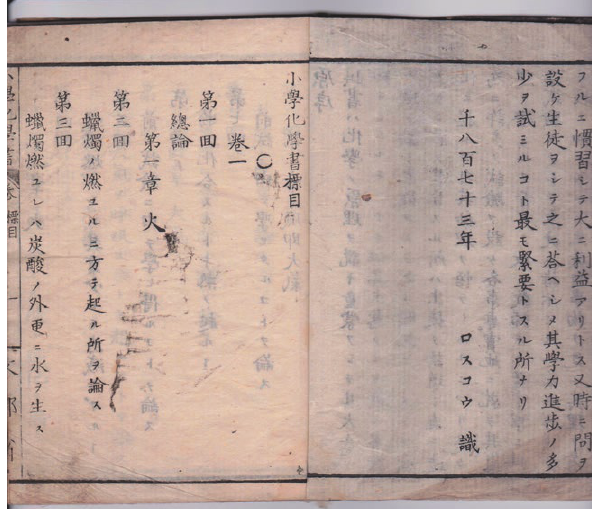
Figure 2. Front page of Roscoe’s book 十八百七十三年 ロスコ ウ 小學化學書標目 1873 Roscoe kogaku kagakusho hyoumoku Chemistry Book for Elementary School